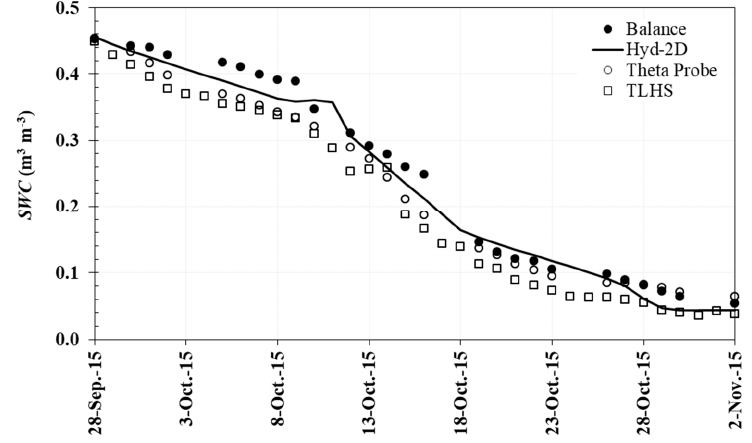
Figure 3. Temporal dynamics of simulated and measured soil water contents during the experimental laboratory